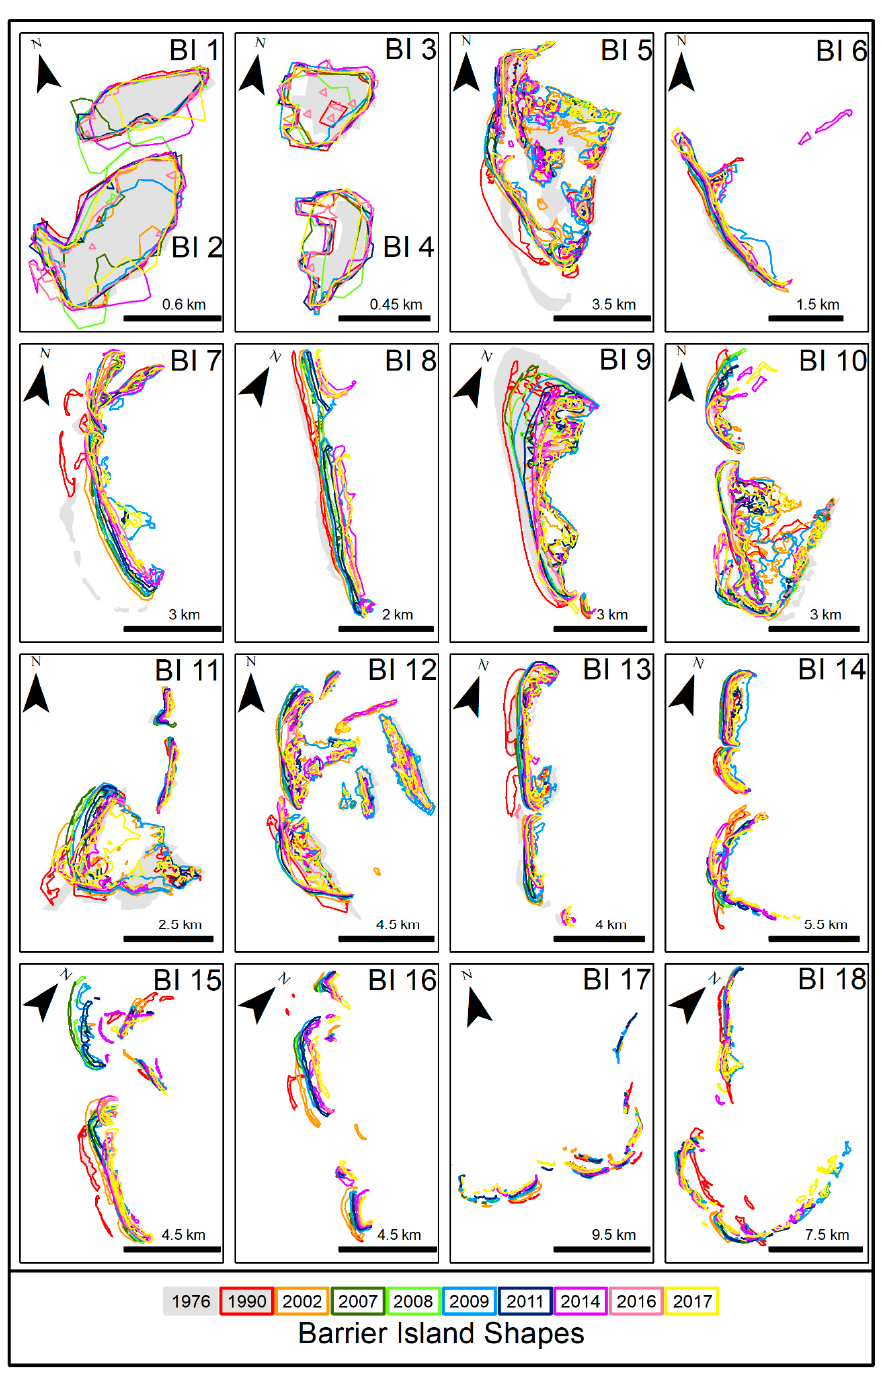
Figure 3. Barrier islands shapes as delineated from 1976 to 2017 from Landsat images.